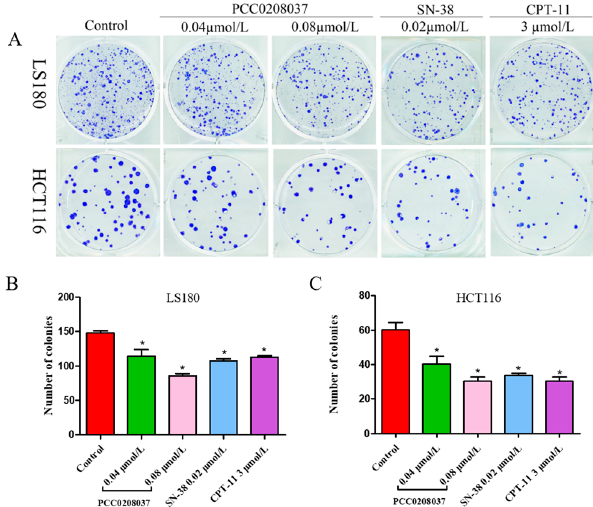
Figure 1. Effects of PCC0208037 on colony formation in CRC cells. ( A ) LS180 and HCT116 cells were cultured with the indicated concentration of PCC0208037 for 12 days. ( B ) Number of clones formed by LS180 cells. ( C ) Number of clones formed by HCT116 cells. The data were expressed as the mean ± SD ( n = 3). * p < 0.05 as compared to the control.